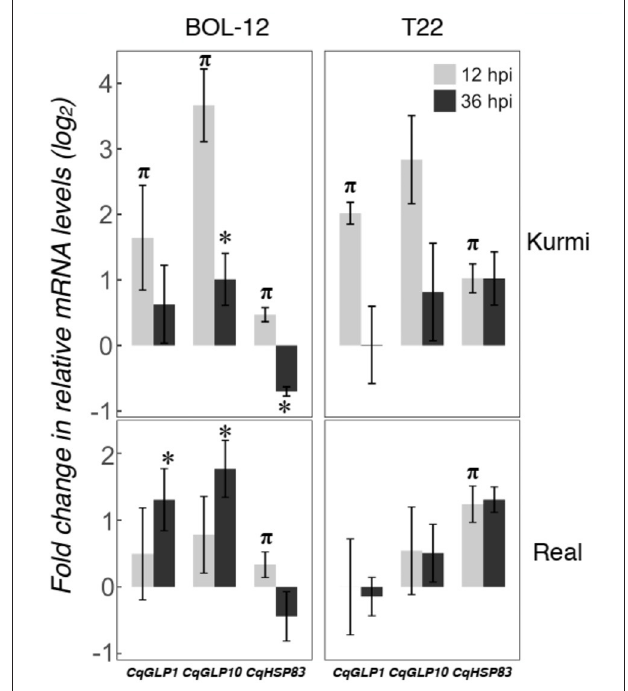
FIGURE 4 | Gene expression at 12 and 36 hpi in representative CqGLPs and CqHSP83 in quinoa roots treated with Trichoderma . Quinoa cv. Kurmi and cv. Real root samples treated with Trichoderma BOL-12 and T22 strains were assessed at 36 hpi by qRT-PCR. mRNA levels were normalized to the CqAct2 reference gene. Fold changes (mean ± SE) were determined by comparing samples treated with Trichoderma against mock-treated ones. Asterisks denote significant changes in the gene expression as compared to the control treatment by qRT-PCR at 36 hpi ( p < 0.05). Symbol π denotes significant changes in the gene expression as compared to the control treatment, using RNA-seq ( p < 0.05) and confirmed by qRT-PCR ( p < 0.05) at 12